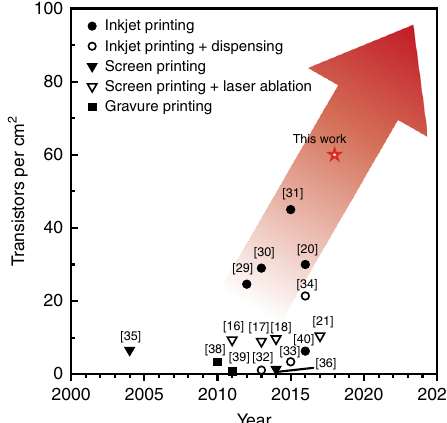
Fig. 7 Transistor density trend of printed organic circuits fabricated by various